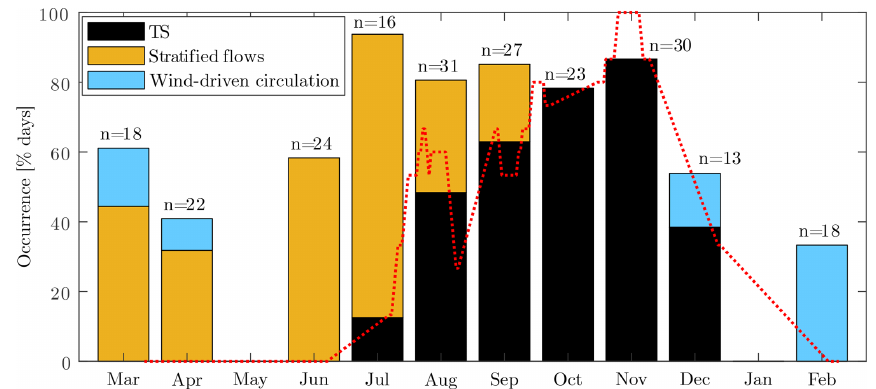
Figure 5. Monthly occurrence of TSs and other cross-shore (southwestward) flows at MT, expressed as a percentage of the days with measurements. The other cross-shore flows are divided between wind-driven circulation ( | L MO | /h ML > 0 . 5) and stratified flows at MT (d T/ d z > 0 . 05 ◦ Cm − 1 ). The red dashed line indicates the 15d moving average of the percentage of occurrence of TSs. The number of days with measurements ( n ) is shown for each month. Months with less than 10d of measurements have been removed (May 2019 and January